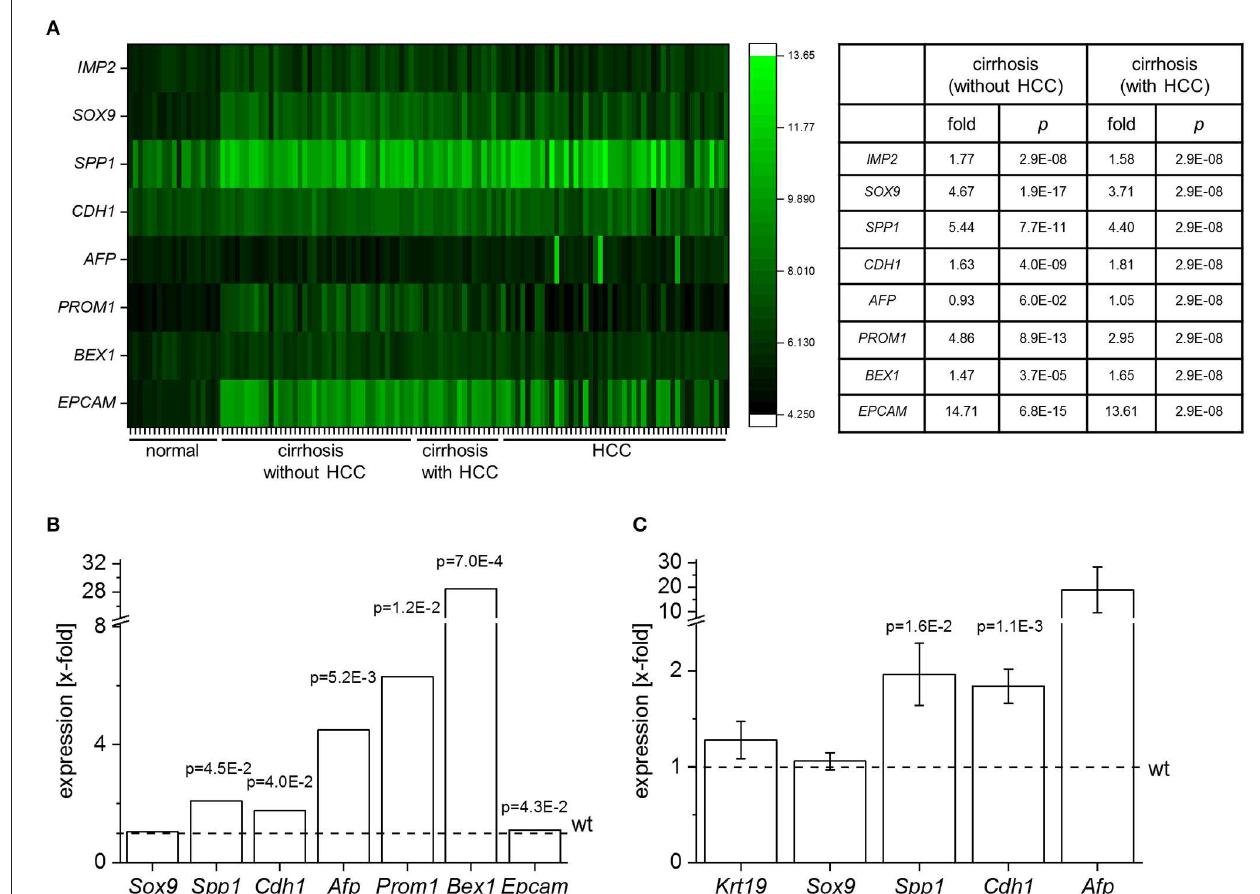
FIGURE 2 | IMP2-2 induces stem cell marker expression. (A) Expression analysis of IMP2 , SOX9 , SPP1 , CDH1 , AFP , PROM1 , BEX1 , EPCAM in human samples of normal liver tissue ( n = 19), cirrhotic tissue (without HCC; n = 41), cirrhotic tissue of HCC-livers (with HCC; n = 17), and HCC tissue ( n = 48) (GSE14323). The table shows expression values as x-fold of healthy ( n = 19) liver samples. P -values were generated by comparison to healthy tissue (Mann Whitney U -test or Welch’s t -test, FDR-corrected by Benjamini-Hochberg method). (B) Gene expression of Sox9 , Spp1 , Cdh1 , Afp , Prom1 , Bex1 , and Epcam in 5 week-old IMP2-2 transgenic animals (tg) determined by micro array analysis ( n = 10 per genotype). Data are expressed as x-fold of wildtype (wt) animals (indicated as dashed line). FDR adjusted p-values are shown. For Afp median value of five different probes is shown (probe 1: x-fold = 17.62, adj. p = 0.002; probe 2: x-fold = 5.35, adj. p = 0.008; probe 3: x-fold = 4.52, adj. p = 0.005; probe 4: x-fold = 1.38, adj. p = 0.009; probe 5: x-fold = 0.95, adj. p = 0.35). (C) Krt19 , Sox9 , Spp1 , Cdh1, and Afp mRNA expression of IMP2-2 tg mice ( n = 13) normalized to the values of wt mice ( n = 13). P -values were calculated in comparison with wt animals (Welch’s t -test, FDR-corrected by